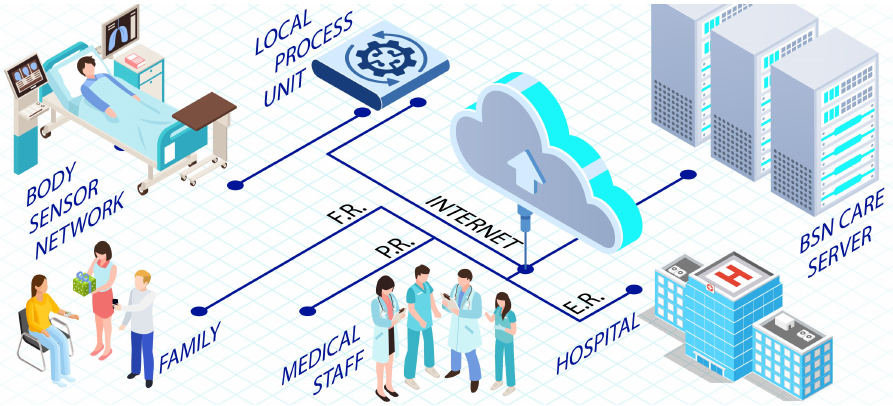
Figure 8. BSN-Care: IoT-based healthcare system using body sensor network as discussed in